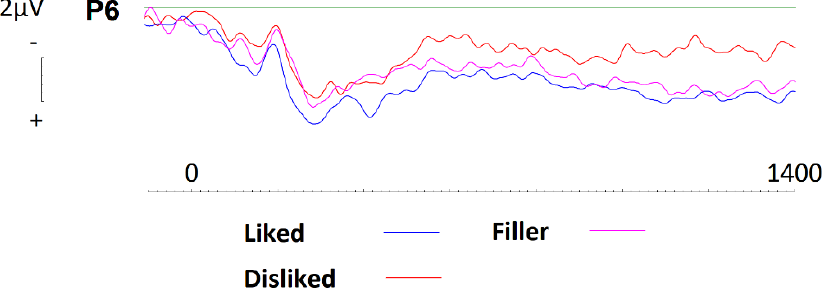
Figure 9. ERPs generated at site P6 during baseline recording for liked, disliked, and filler brands. Disliked brands were seen to elicit significant less activity than liked or neutral brands.